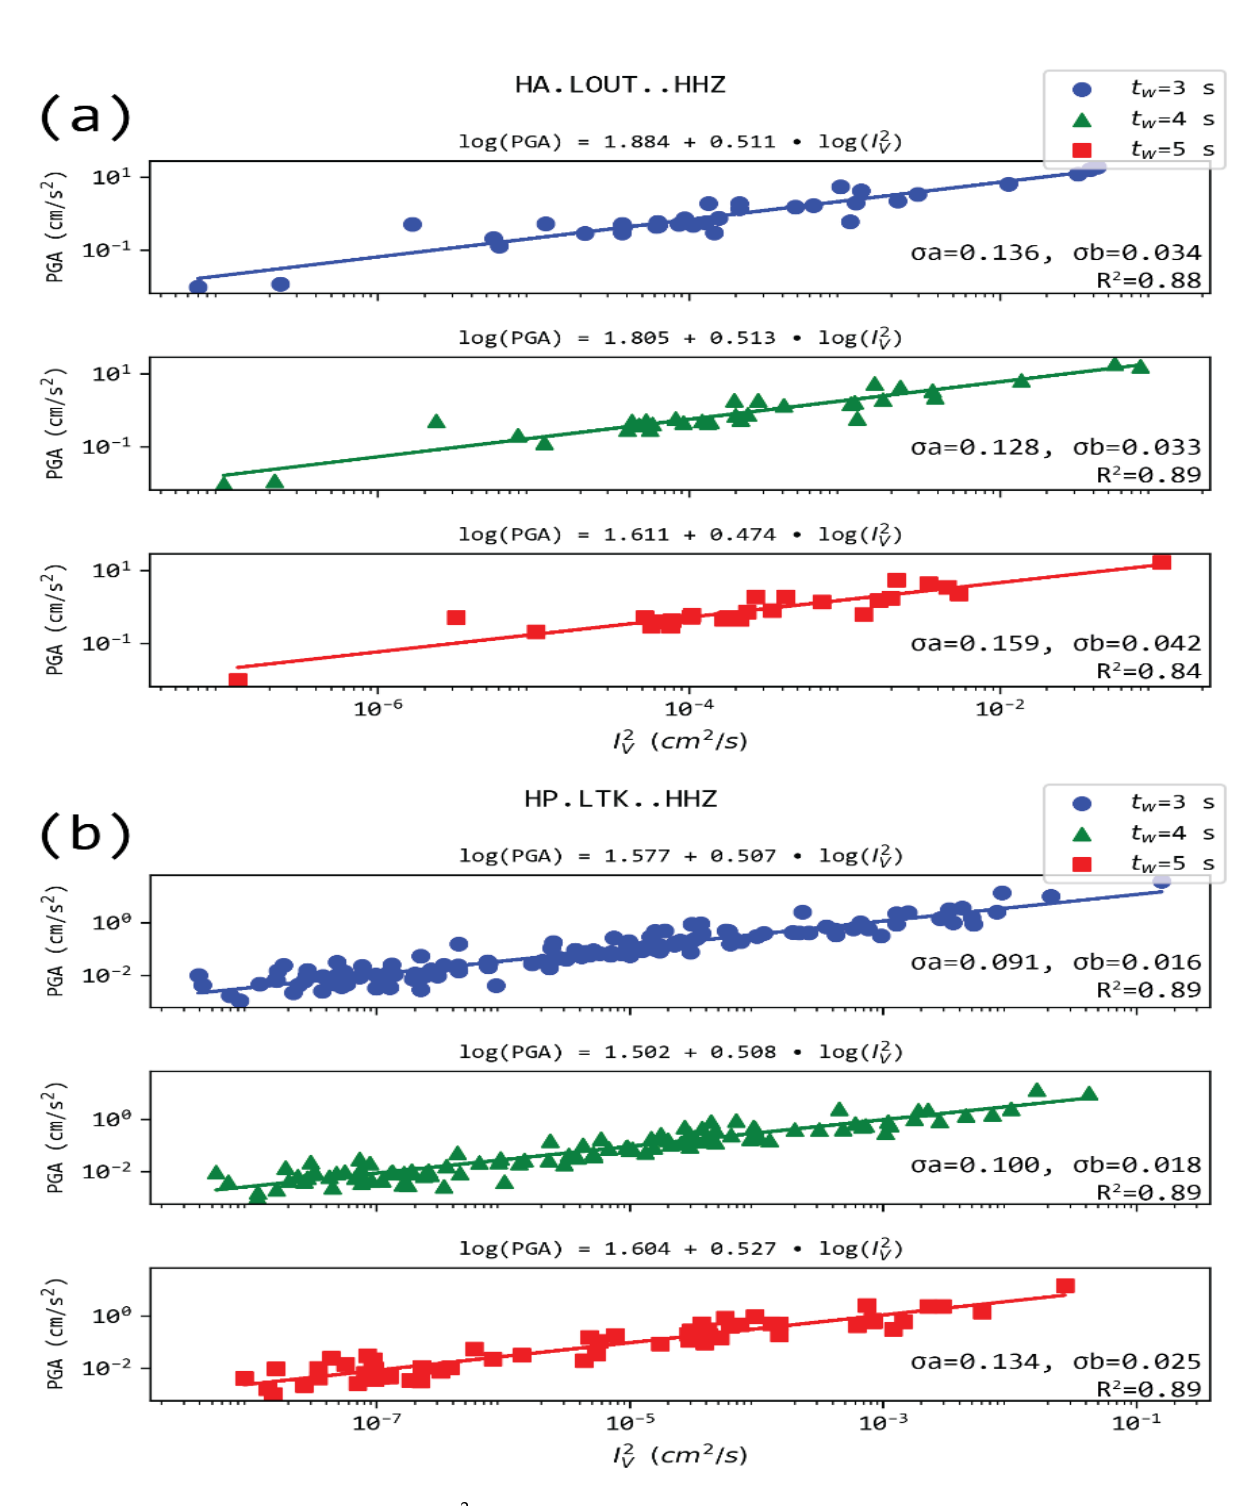
Figure 9. Regression models of PGA and I 2 υ for the two stations located in Loutraki, i.e., LOUT ( a ) and LTK ( b ), for the three time-windows (t w ) after the P arrival. The rest of the notation as in Figure 3. The logarithms of the two quantities show a very high correlation.